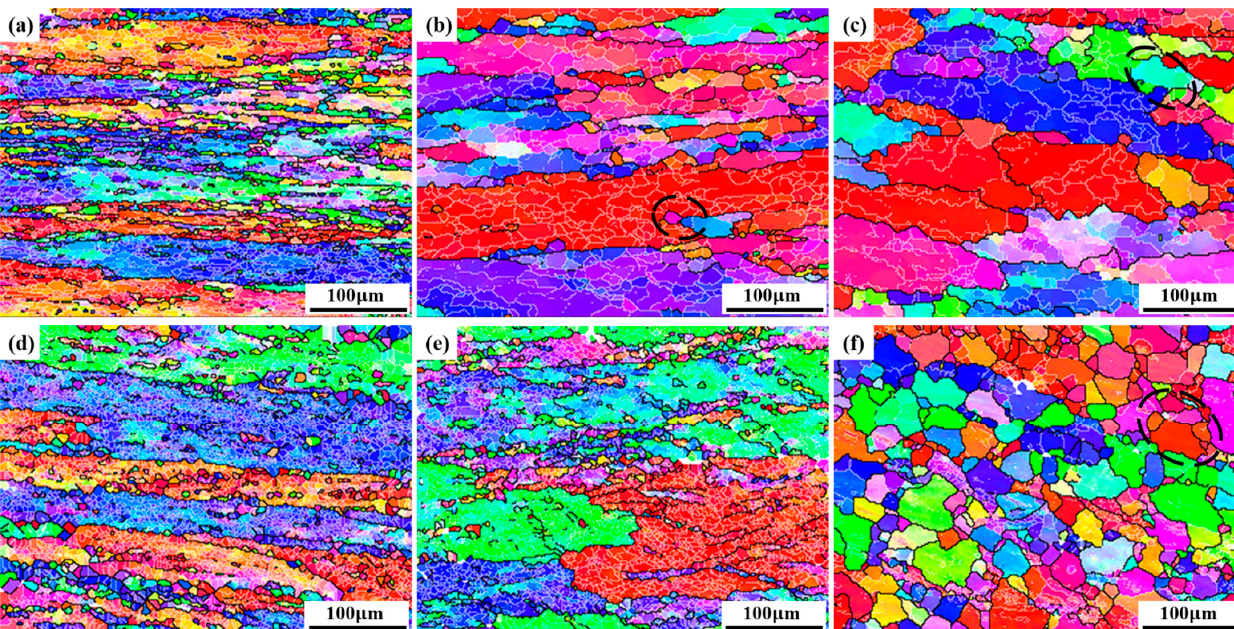
Figure 7. IPF maps of the AC AA2195 Al-Li alloy under different thermal deformation conditions: ( a ) 360 °C, 0.01 s − 1 ; ( b ) 420 °C, 0.01 s − 1 ; ( c ) 480 °C, 0.01 s − 1 ; ( d ) 360 °C, 0.01 s − 1 ; ( e ) 420 °C, 0.01 s − 1 ; ( f ) 480 °C, 0.01 s − 1 .